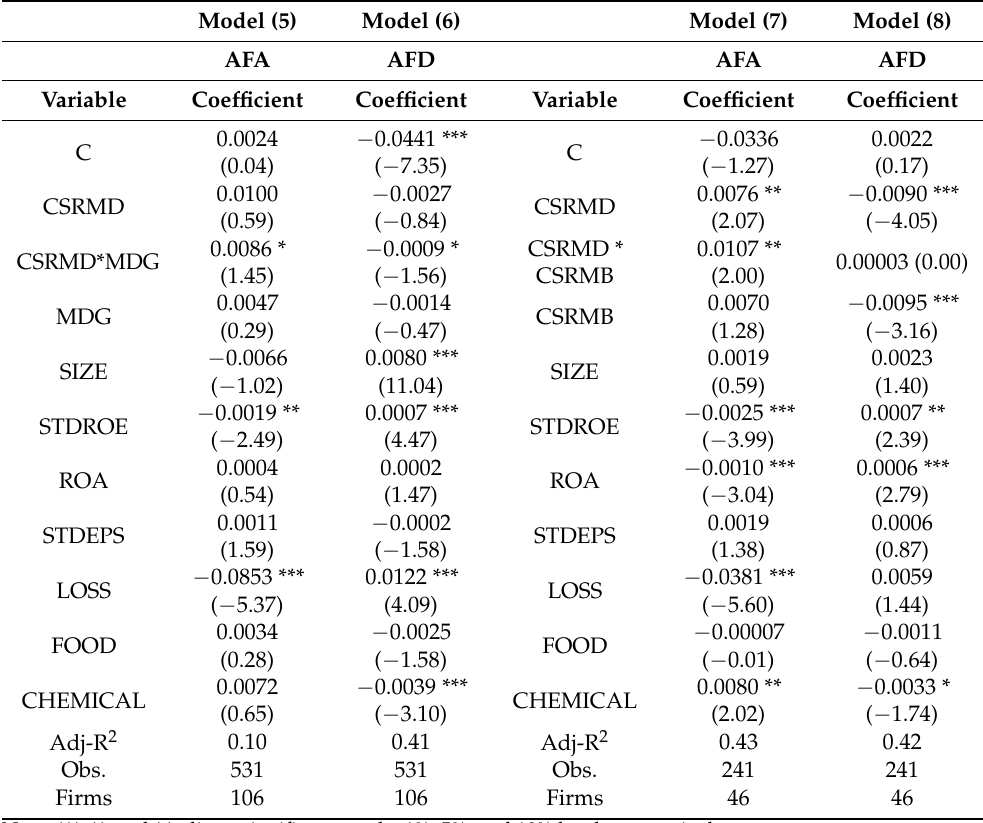
Table 5. Empirical results—further